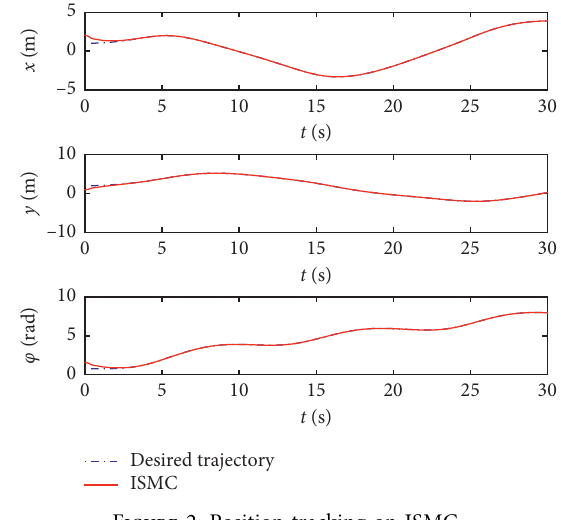
Figure 2: Position tracking on ISMC.